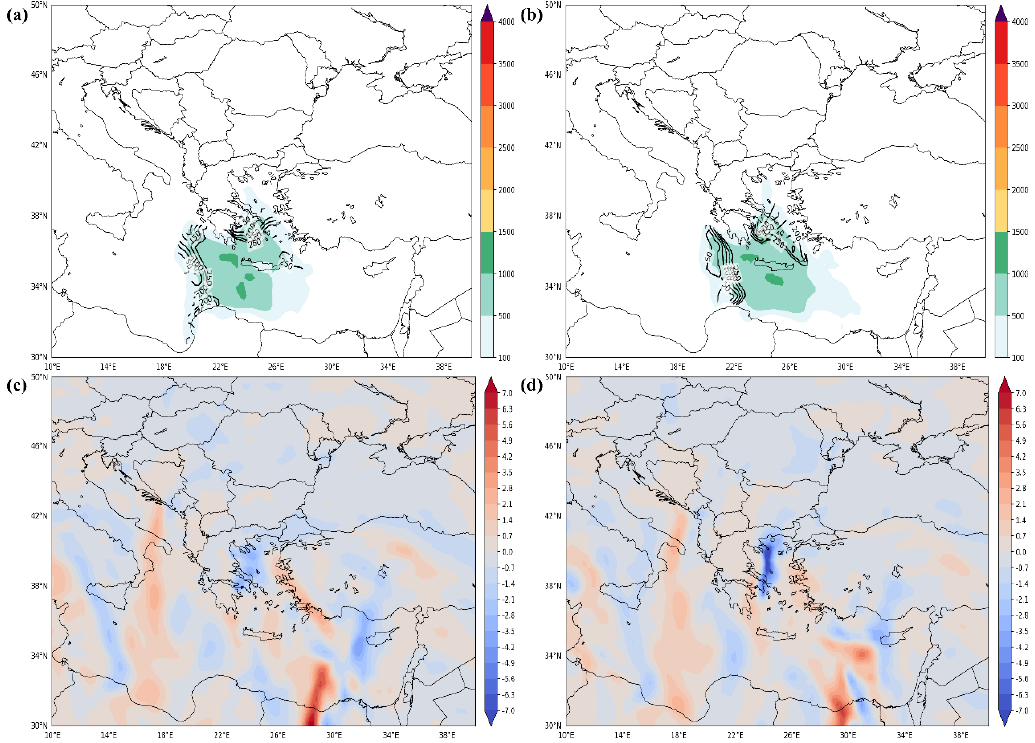
Figure A3. CAPE (shading; J kg −1 ) and CIN (contours; J kg −1 ; a , b ), and VIMD (kg m −2 ; c , d ) from the 0.25° × 0.25° ERA5 reanalysis data on 22 February 2013, 0600 UTC ( a , c ) and 0800 UTC ( b , d ).